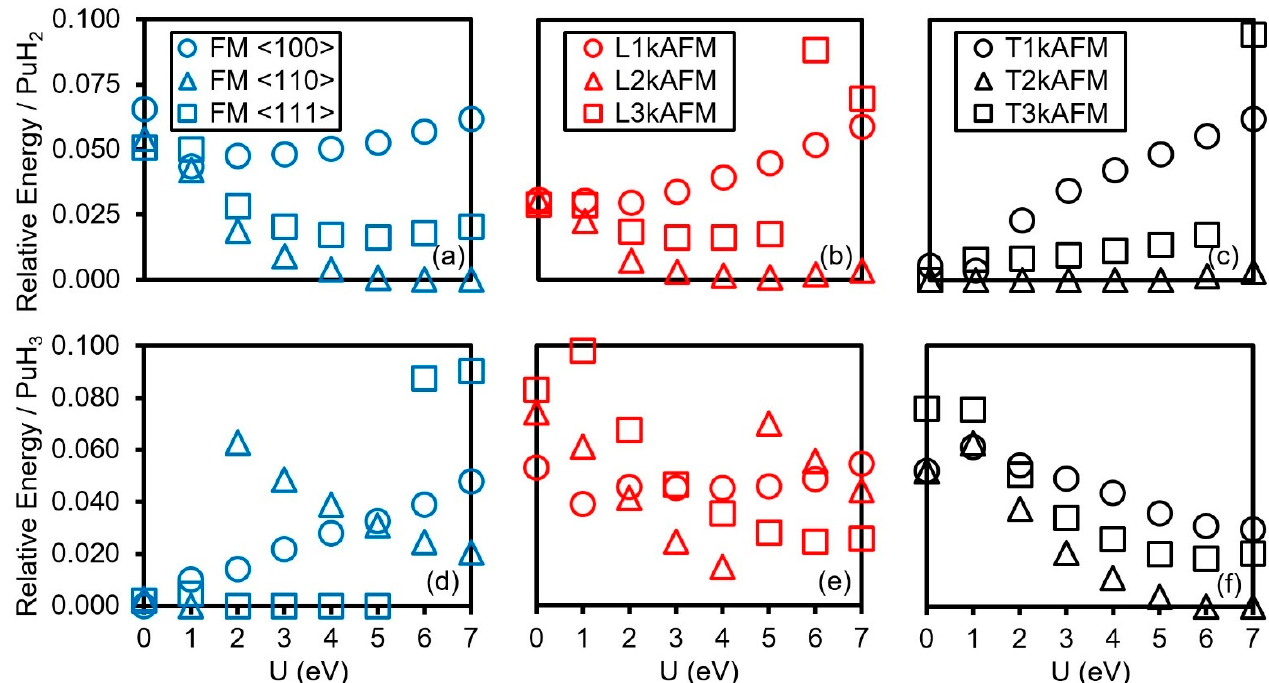
Figure 4. Relative energies per formula unit for cubic PuH 2 ( a ) FM <100>, <110>, <111>, ( b ) longitu- dinal AFM 1k, 2k and 3k, and ( c ) transverse AFM 1k, 2k and 3k, and for PuH 3 ( d ) FM <100>, <110> and <111>, ( e ) longitudinal AFM 1k, 2k and 3k, and ( f ) transverse AFM 1k, 2k and 3k calculated with PBEsol+ U +SOC (0 ≤ U ≤ 7 eV).